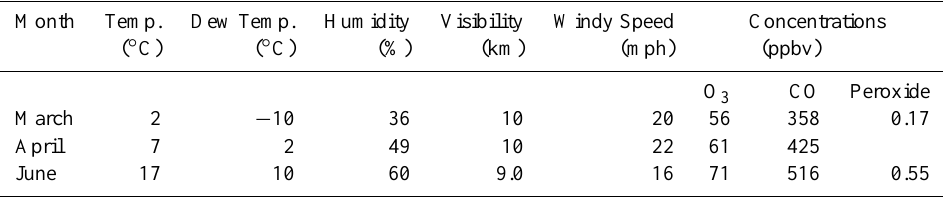
Table 3. Meteorological conditions and concentrations of gases (O 3 , CO, Peroxide) in ambient air at MT. Month Temp. Dew